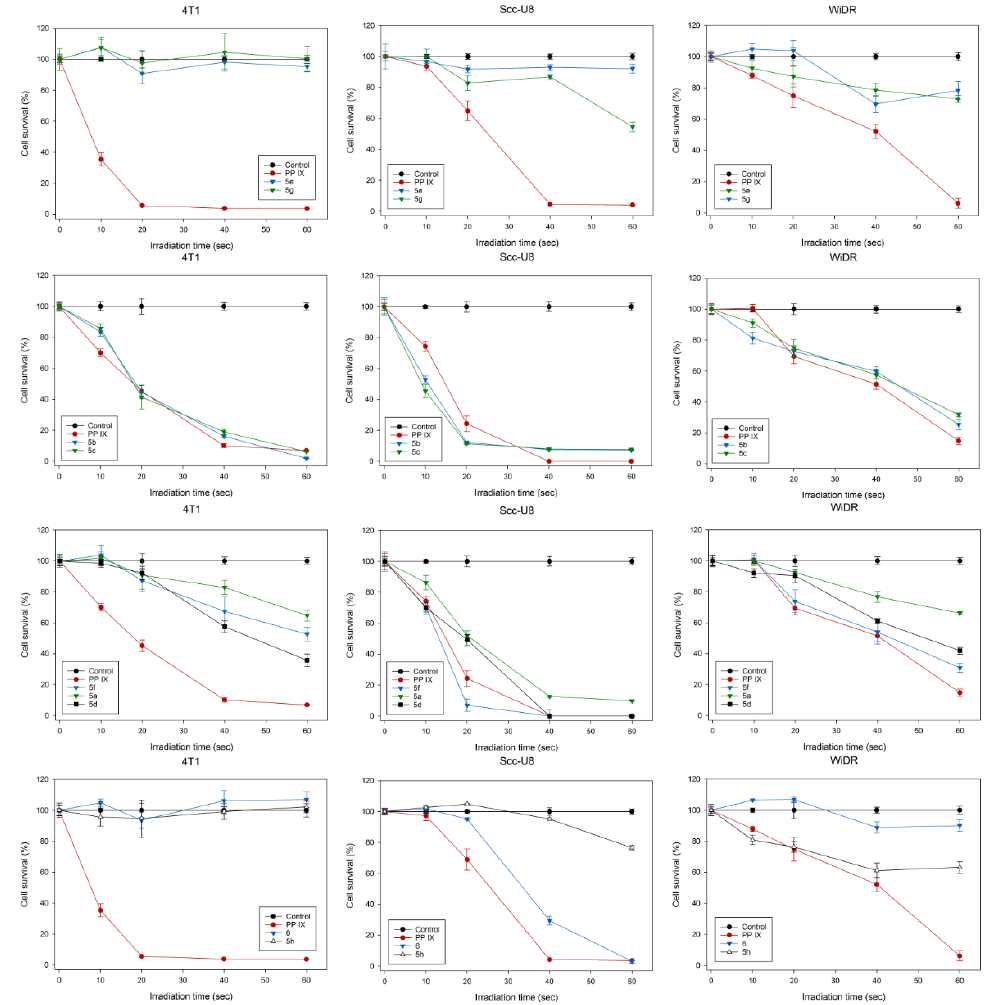
Figure 1. PDT of tumor cells with native PpIX and PpIX derivatives, 5a – h and 6